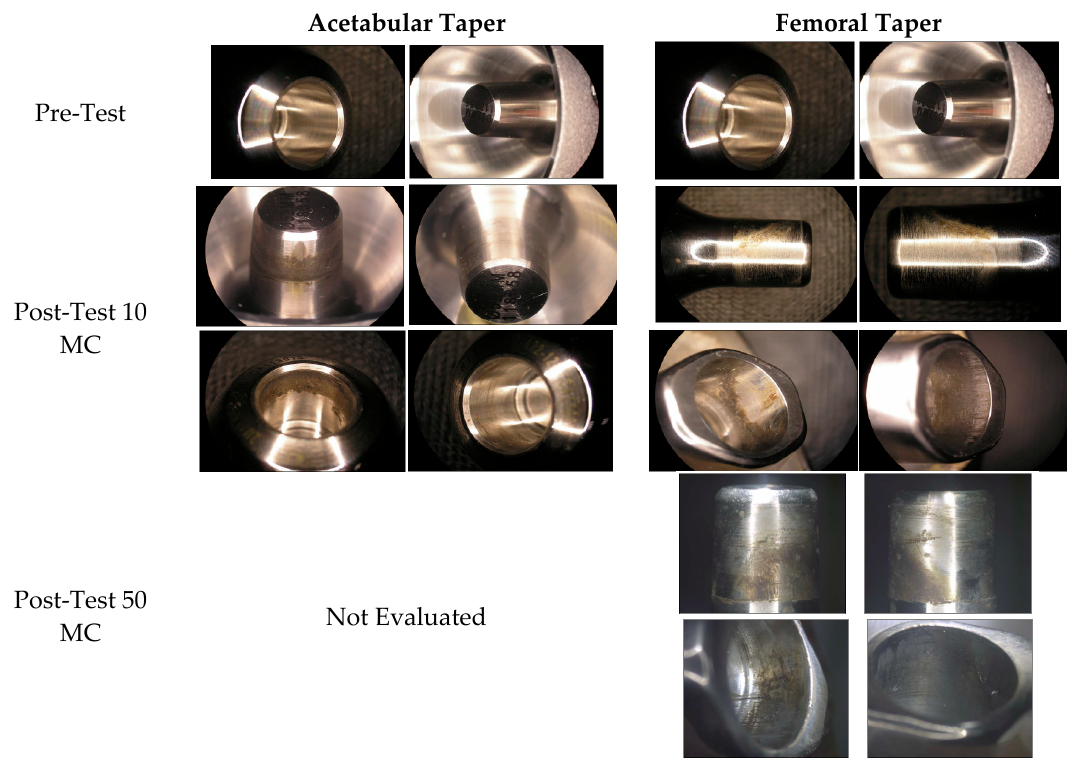
Figure 4. Representative examples of both acetabular and femoral tapers both pre- and post-testing for 10 and 50 million cycles.